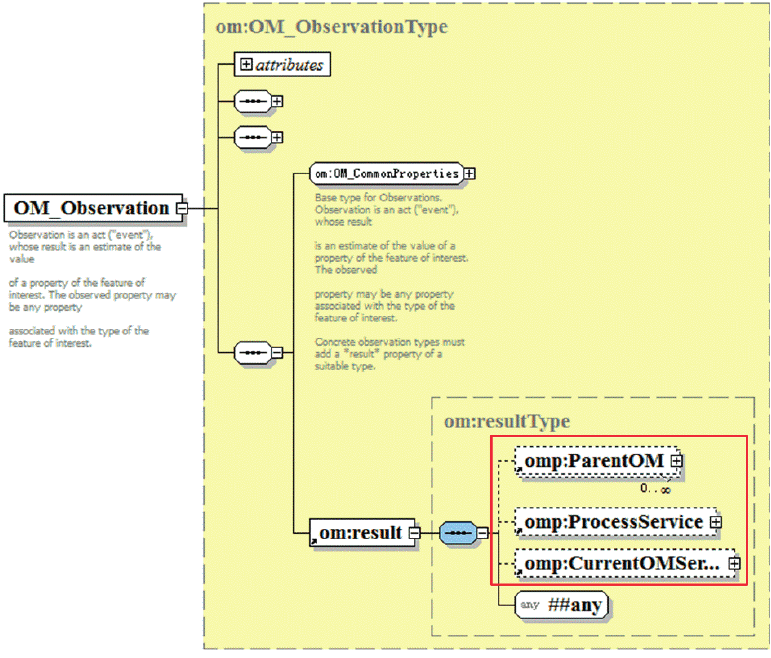
Figure 6. Extended elements in